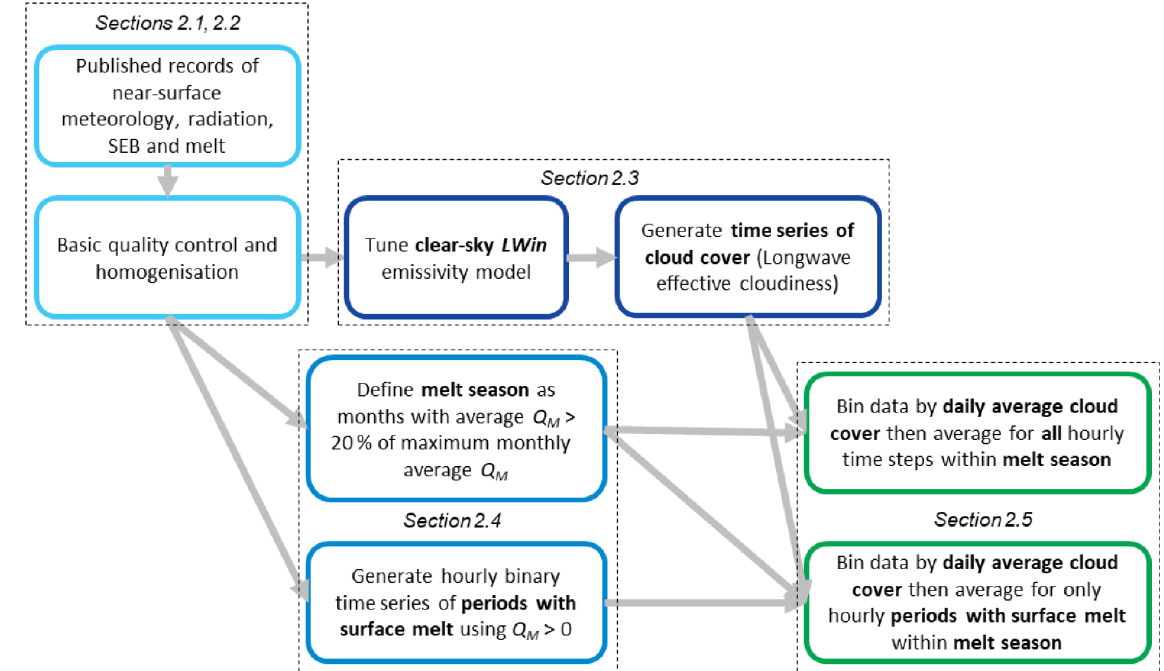
Figure 3. Steps used to process and analyse data, annotated with relevant sections of the methods.